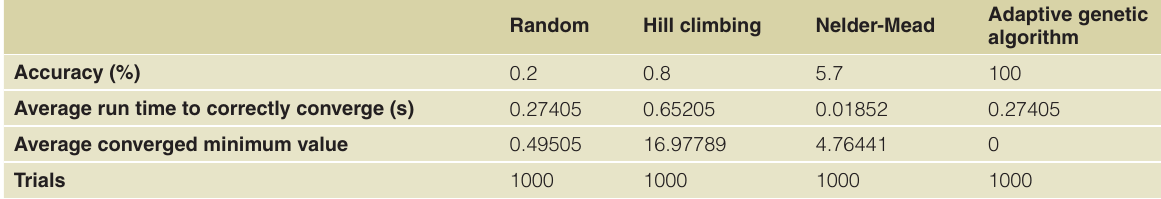
Table 5. Summary of results for solving the Rastrigin function minimization problem using various search algorithms.